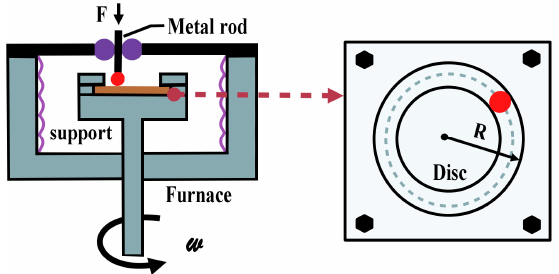
Figure 1. Friction principle experimental